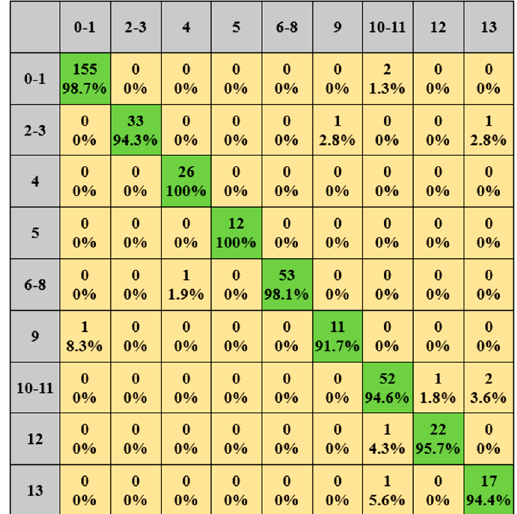
Figure 9. REDD dataset identi fi cation results. ( Green means true, yellow means false )